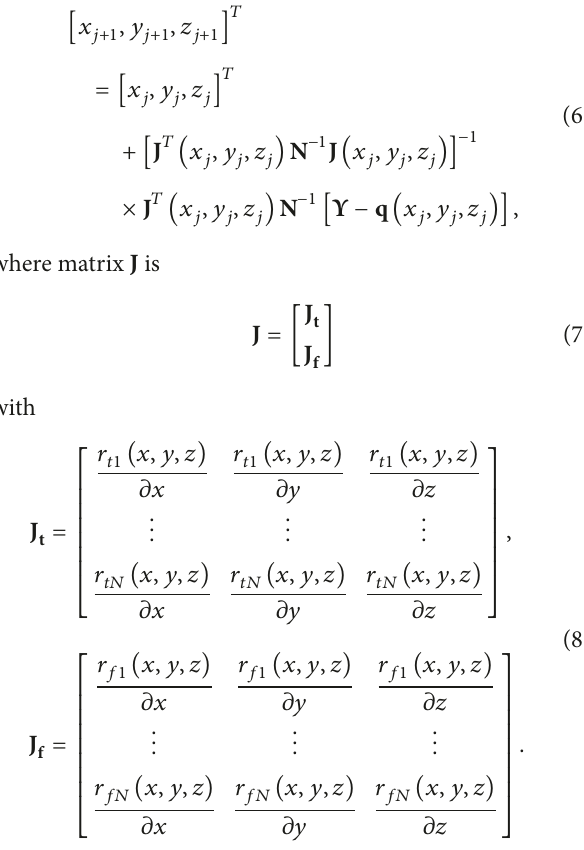
The initial position in (6) needs to be defined in advance; the method for determining the initial position (shown in ∘ . Figure 1) is as follows: (1) setting up a grid with the units of 1 The grid is centered on the midpoint (𝑔 𝜆𝑜 , 𝑔 𝜑𝑜 ) of the satellite ground trajectory (the track generated during AIS signals transmission) and the range of grid geodetic coordinates , 𝑔 ) is {𝑔 − 𝛽/2 ≤ 𝑔 ≤ 𝑔 + 𝛽/2, 𝑔 − 𝜀/2 ≤ 𝑔 ≤ (𝑔 𝜆 𝜑 𝜆𝑜 𝜆 𝜆𝑜 𝜑𝑜 𝜑 + 𝜀/2} , where 𝛽 and 𝜀 are the maximum visible longitude 𝑔 𝜑𝑜 and latitude of satellite, respectively. (2) Connecting the start and end points of the satellite ground trajectory and dividing the grid into 𝑆 1 and 𝑆 2 (two parts) by extending the connecting line. (3) Searching within each part of grid {𝐸 = and selecting two points with (𝑚 𝜆𝑖 , 𝑚 𝜑𝑖 ) = arg max {𝑆 𝑖 } − ̂𝑓) 2 } ( 𝑖 = 1, 2 ). In the cost function 𝐸 , 𝑓 1/(𝑓 𝑟 𝑟 is ̂𝑓 = 𝑓 {1 − the measured frequency of the AIS signal and 𝑐 ( L − L )/𝑐| L − L |)} is the estimated frequency of ( V T si g si g si = [𝑥 , 𝑦 , 𝑧 ] T received signal at the grid point, where L 𝑔 𝑔 𝑔 g